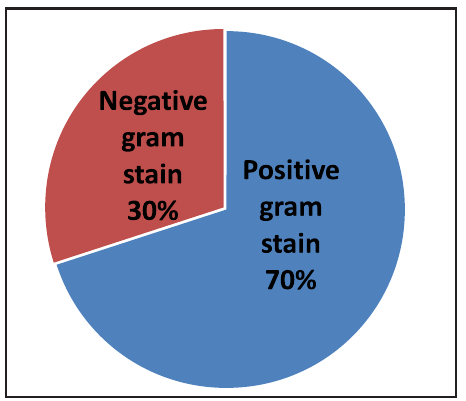
Fig. 2. Pie chart of percentage distribution for bacteria according to gram